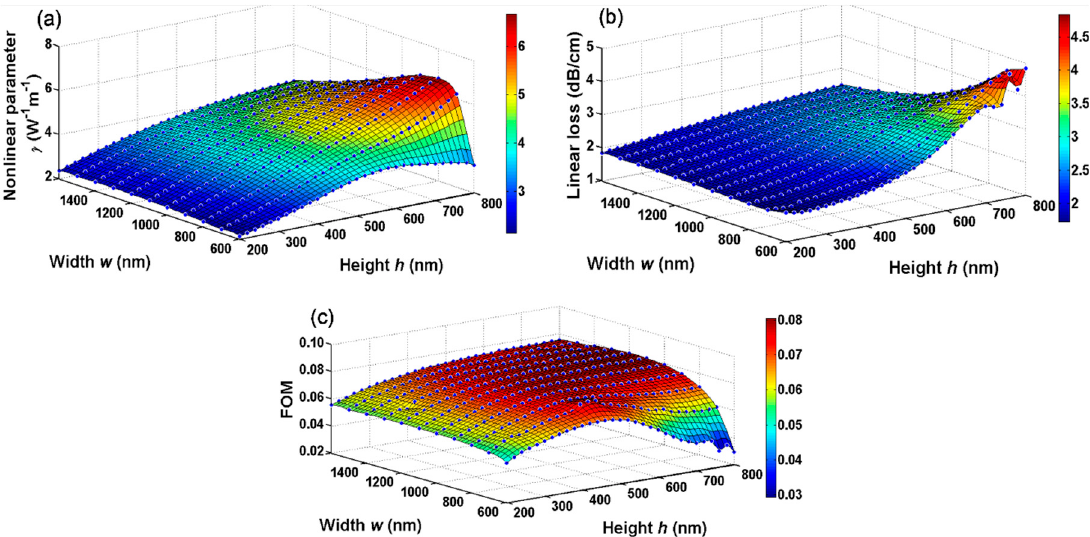
Figure 6. The calculated waveguide nonlinear parameter γ ( a ), linear loss α ( b ) and figure of merit (FOM) ( c ) of a silicon-rich nitride ridge waveguide with respect to the width w and rib height h . Here, the total height H is fixed at 800 nm.